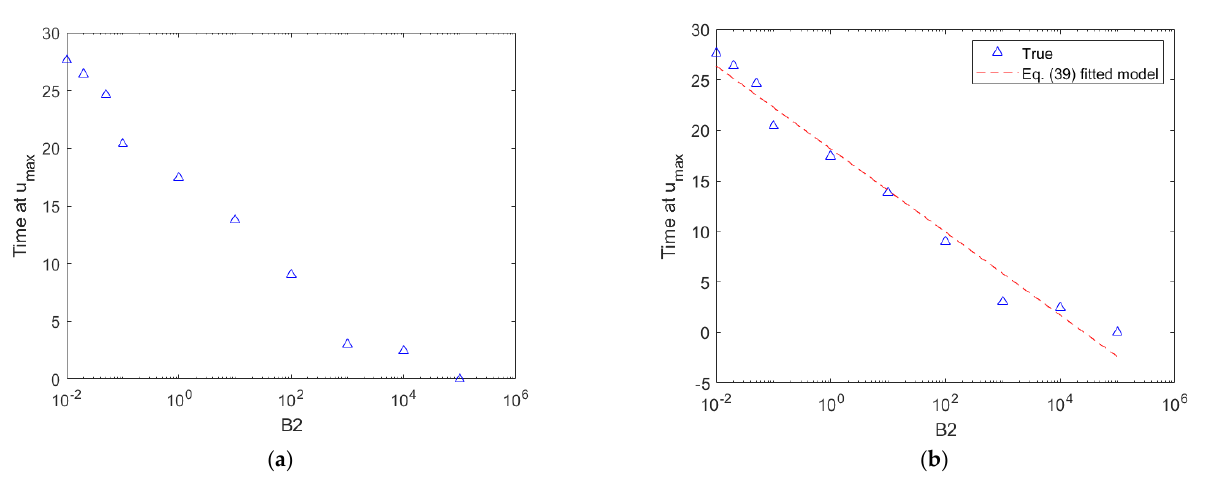
Figure 16. The t max time against parameters B 2 for the application of Policy 1: ( a ) The t max time against parameters B 2 ; ( b ) the t max time against parameters B 2 , versus the fitted model.